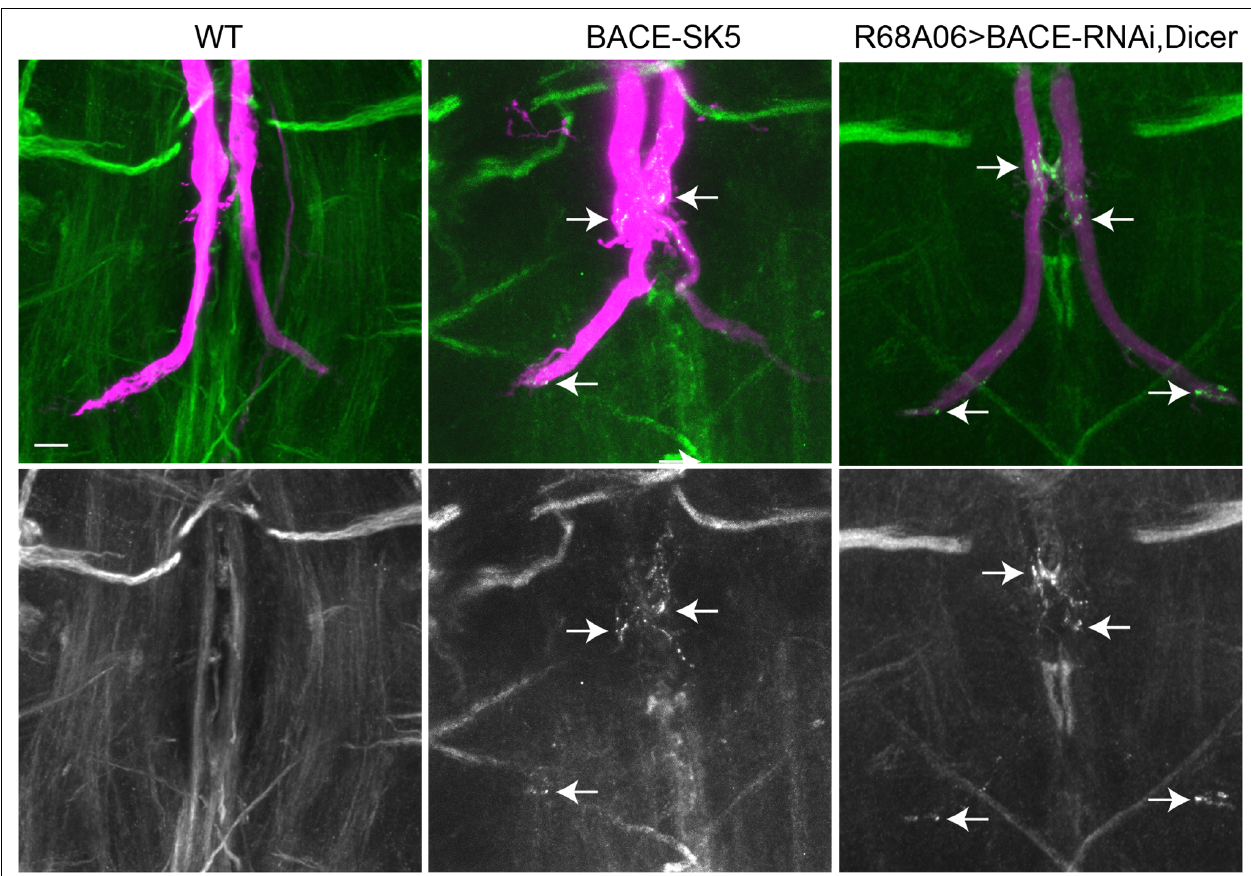
FIGURE 6 | Nrg localization in BACE mutants. Endogenous Nrg was labeled with BP104 antibodies (green) in BACE-SK5 null mutant and in animal co-expression UAS-BACE-RNAi and UAS-Dicer with R68A06-Gal4. The GFs were dye-injected with rhodamine-dextran (magenta). Nrg accumulations in GF terminals are indicated by arrows. Scale bar represents 10 µ